Question: Describe this figure in one sentence.
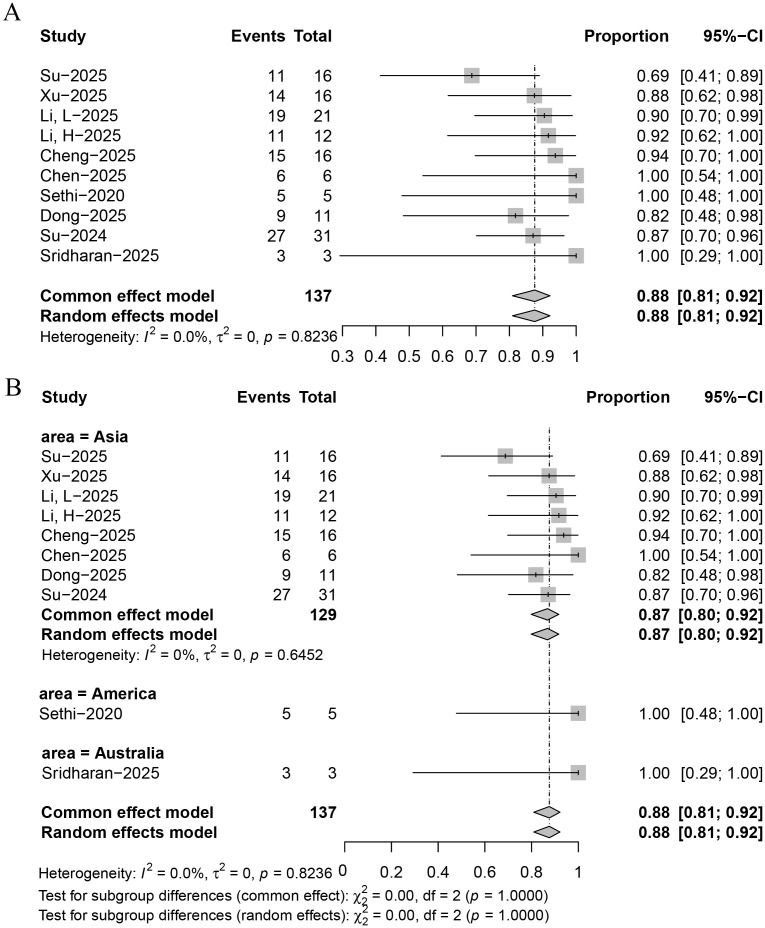
Answer: (A) Forest plot of the immune remission rate; (B) Forest plot of the subgroup analysis of area for the immune remission rate.